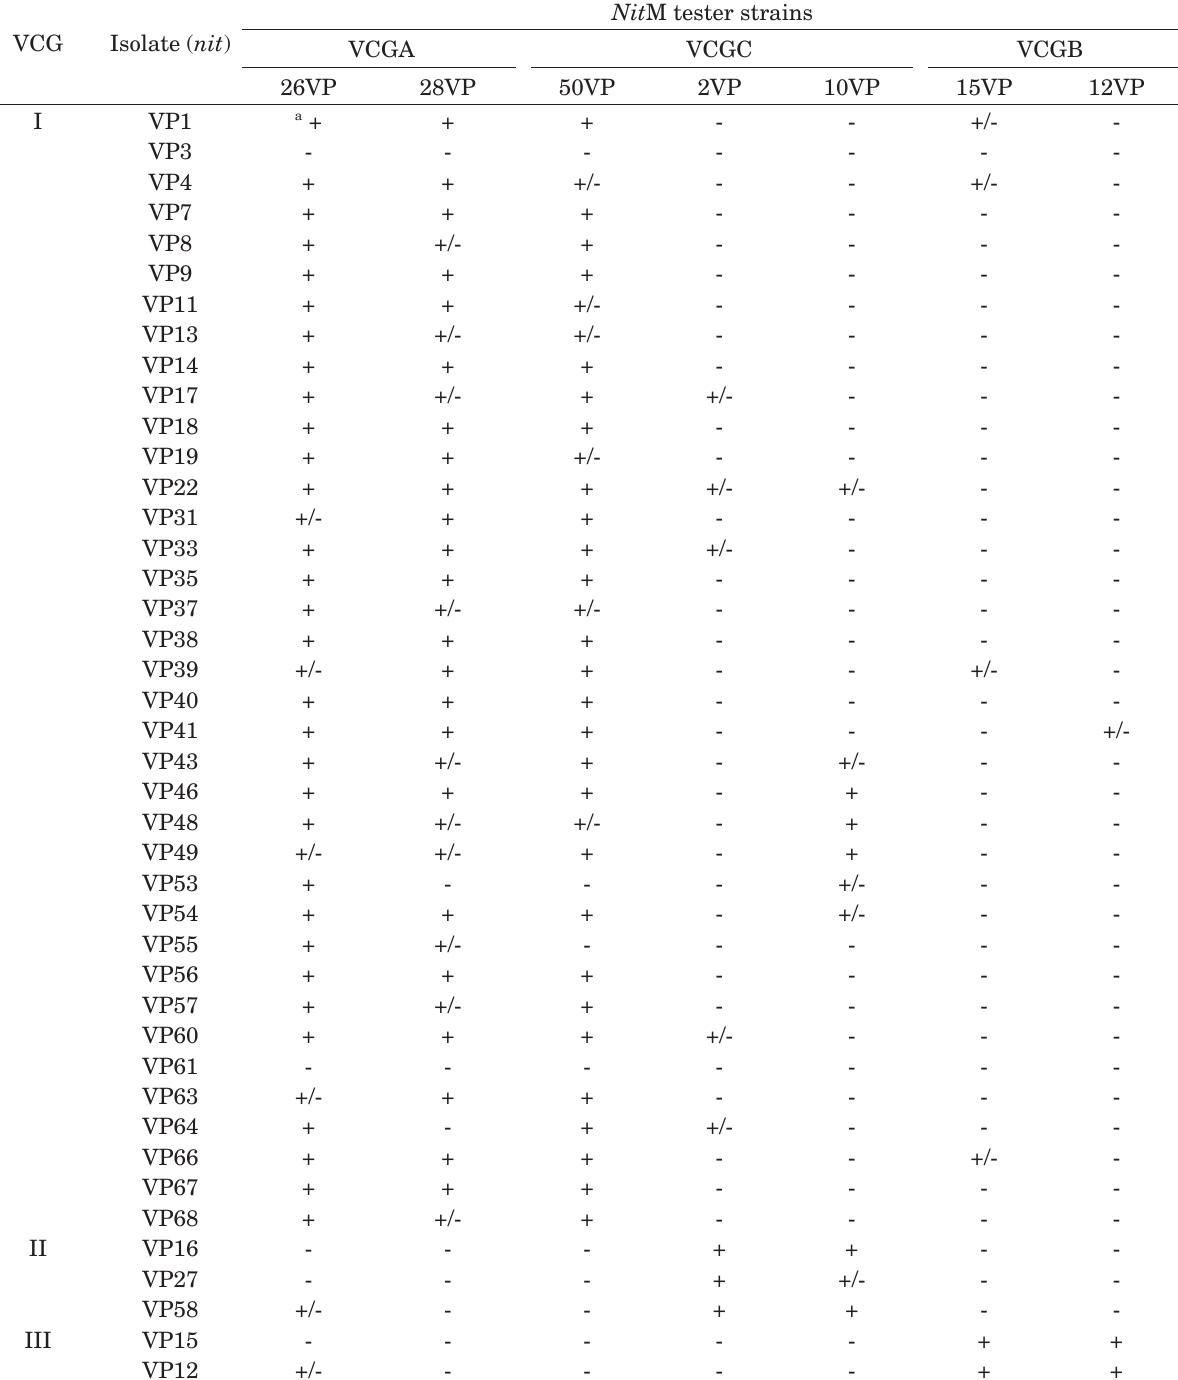
Table 2. Complementation test between nit 1 mutants from 42 pistachio isolates and seven Nit M mutant testers from three local vegetative compatibility groups (VCGs) of Verticillium dahliae